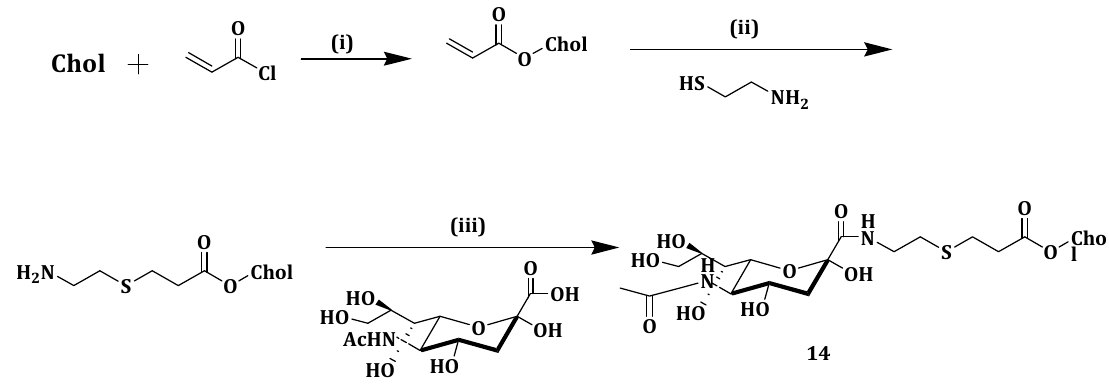
Table 3. IC 50 values of different EPI formulations in S180 and RAW264.7 cell lines.